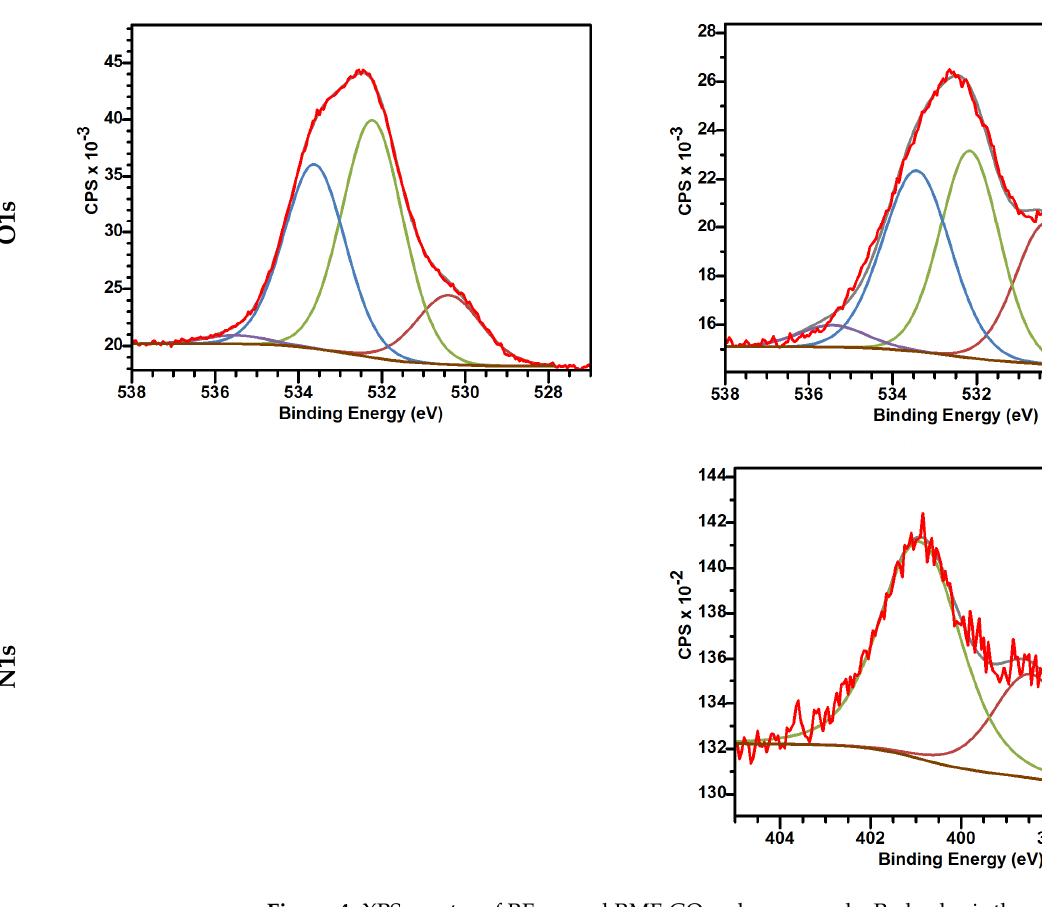
Figure 4. XPS spectra of RF_ac and RMF-GO carbon aerogels. Red color is the region of the spectrum corresponding to the different elements. These curves were decomposed according to the various binding states listed in Tables 4 and 5.